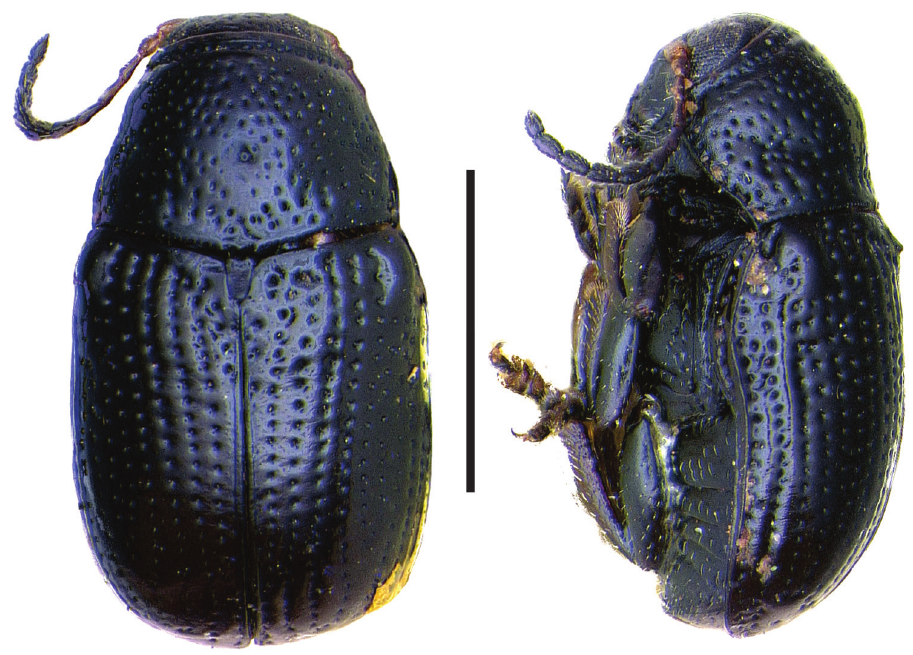
Figure 21. Cryptocephalus carbonarius Burmeister (2) , left: habitus (dorsal view), right: habitus (lateral view).